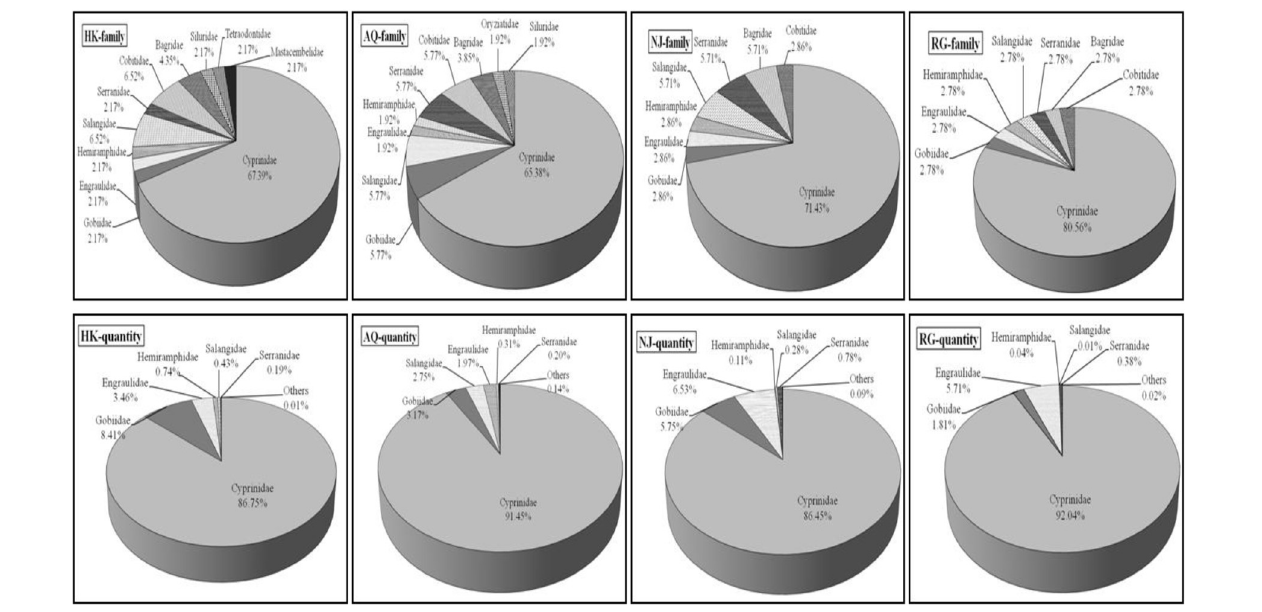
FIGURE 2 | Families and quantity percentage of ichthyoplankton in different sections.